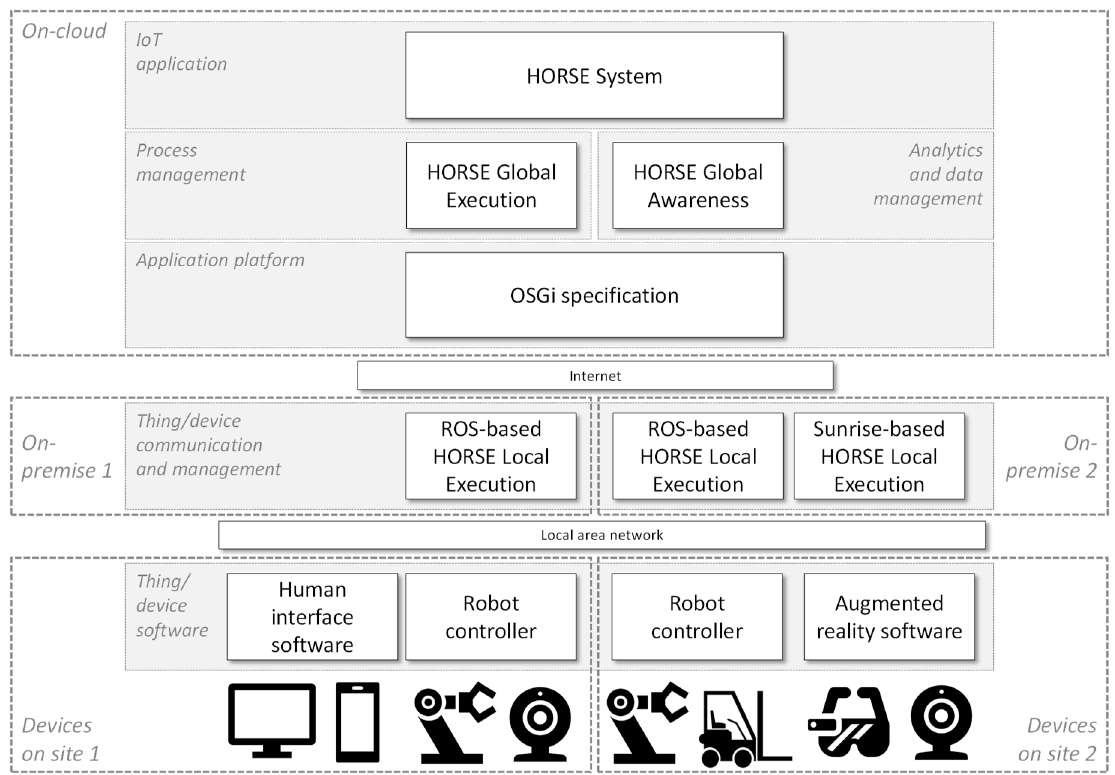
Figure 16. HORSE technology stack expanded to include multiple sites.